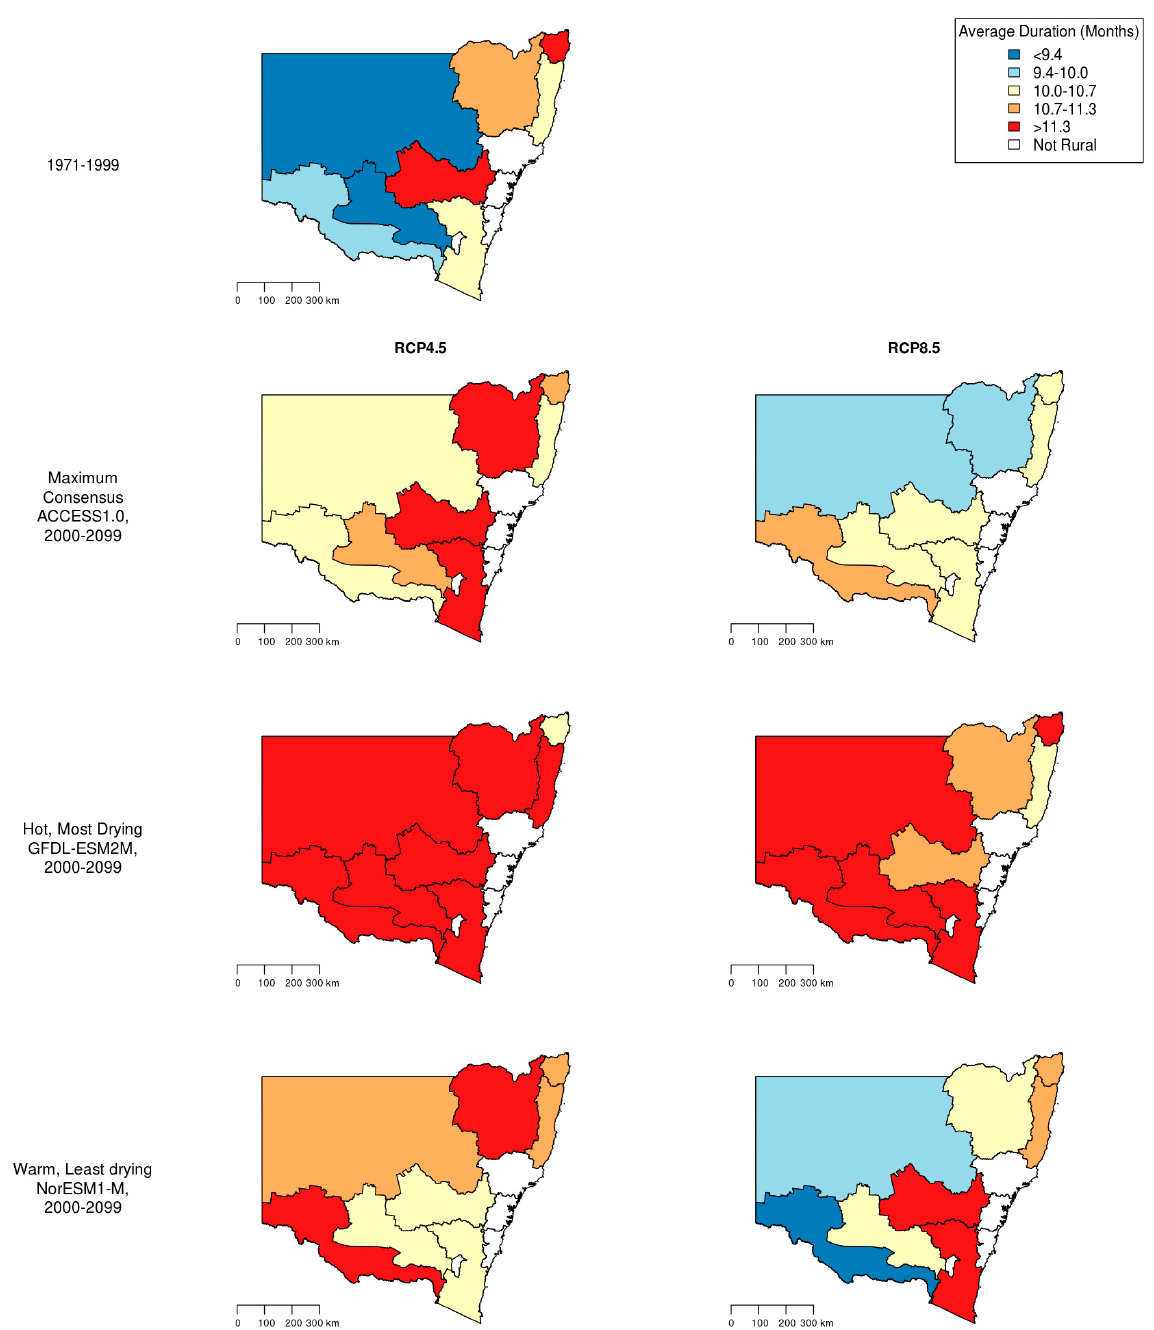
Figure 2. Average drought durations in rural NSW statistical divisions (SDs) during 1971–1999 and in future general circulation models (GCM) and representative concentration pathway (RCP) scenarios (2000–2099); RCP8.5 and RCP4.5 represent high and lower emissions, respectively. ACCESS1.0 was the model with maximum consensus, GFDL-ESM2M was the hotter and drier model and NorESM1-M was the low warming, wetter